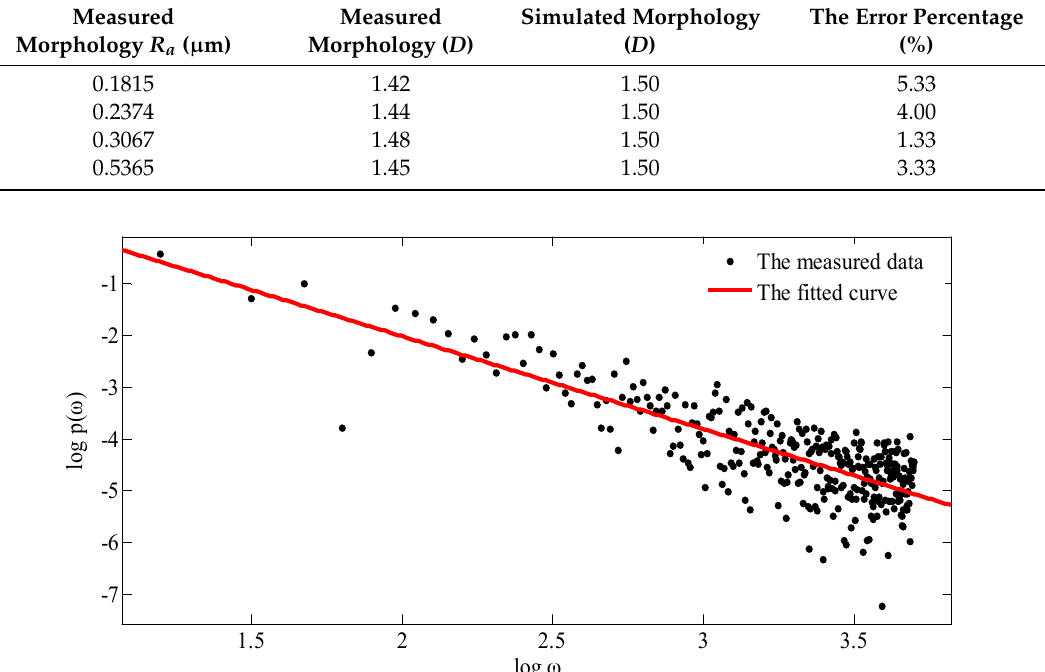
Table 4. Error percentages of simulated and actual morphologies.